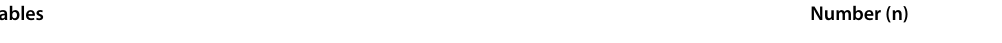
Table 1 Characteristics of participants